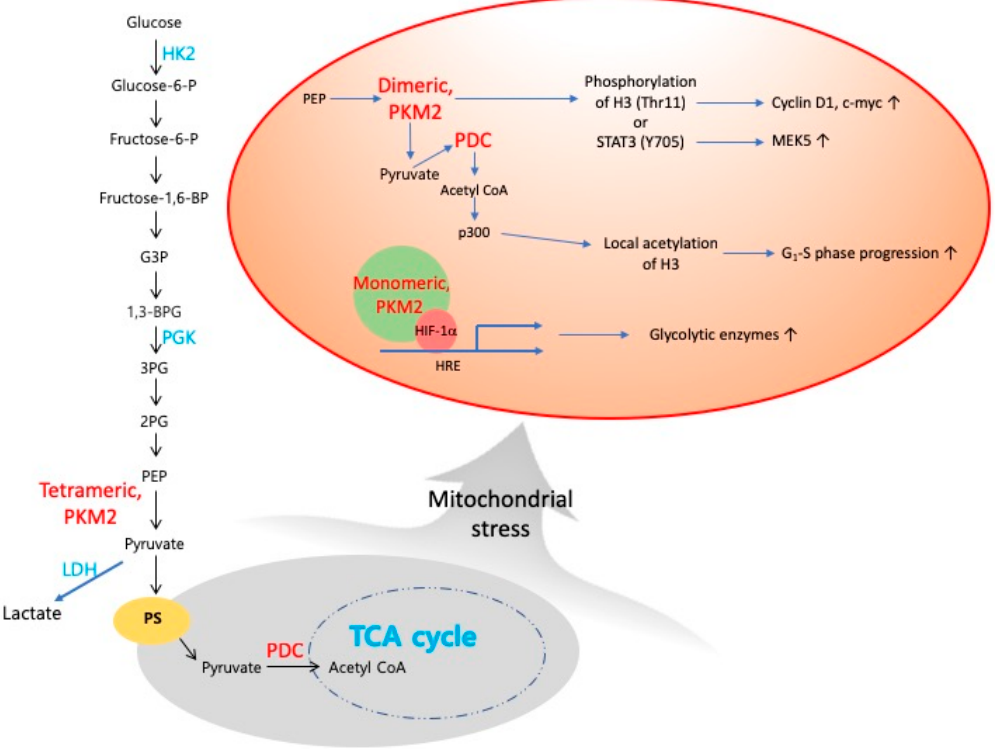
Figure 2. Translocation of PKM2 or PDC into nucleus, where it serves as transcriptional coactivator and as a protein kinase or as a producer of acetyl CoA to modulate transcriptional program. In nucleus, dimeric PKM2 becomes a protein kinase using PEP as a phosphate donor. PKM2 is able to phosphorylate STAT3 at Y705 and promotes transcription of MEK5. PKM2 directly binds to and phosphorylates histone H3 at threonine 11 upon epidermal growth factor (EGF) receptor activation [109] . PKM2 can function as a transcriptional coactivator, promoting HIF-1 α binding activity to DNA and thereby participating in a positive feedback loop with HIF-1 α [114]. Grey circle denotes mitochondrial events and orange circle indicates nuclear events. Subcellular localization of glycolytic metabolites and tetrameric PKM2 is in cytoplasm. PKM2 and PDC are shown in red. Canonical cytosolic functions of HK2, LDH and PGK are shown here in blue. Abbreviations: G3P, glyceraldehyde 3-phosphate; 3PG, 3- phosphoglyceraste; 2PG, 2-phosphoglyceraste; PEP, phosphoenolpyruvate; PDC, pyruvate dehydrogenase complex; PS, pyruvate symporter.